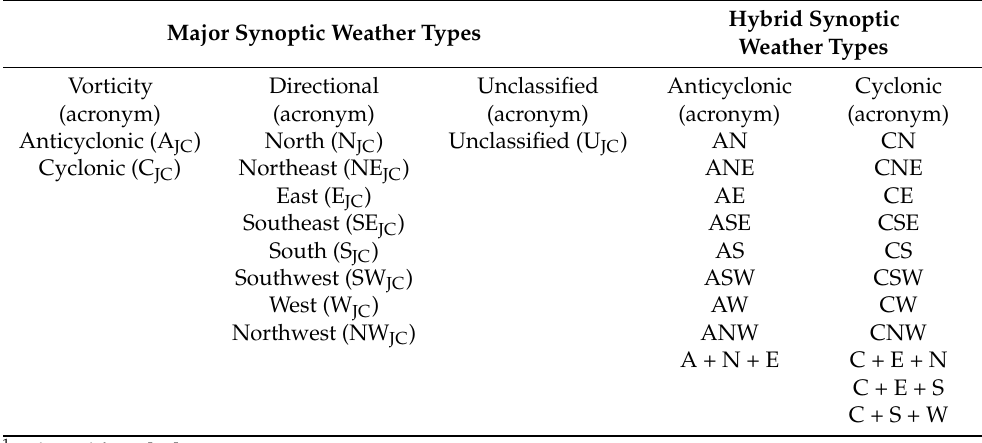
Table 3. Jenkinson–Collison major synoptic weather types 1